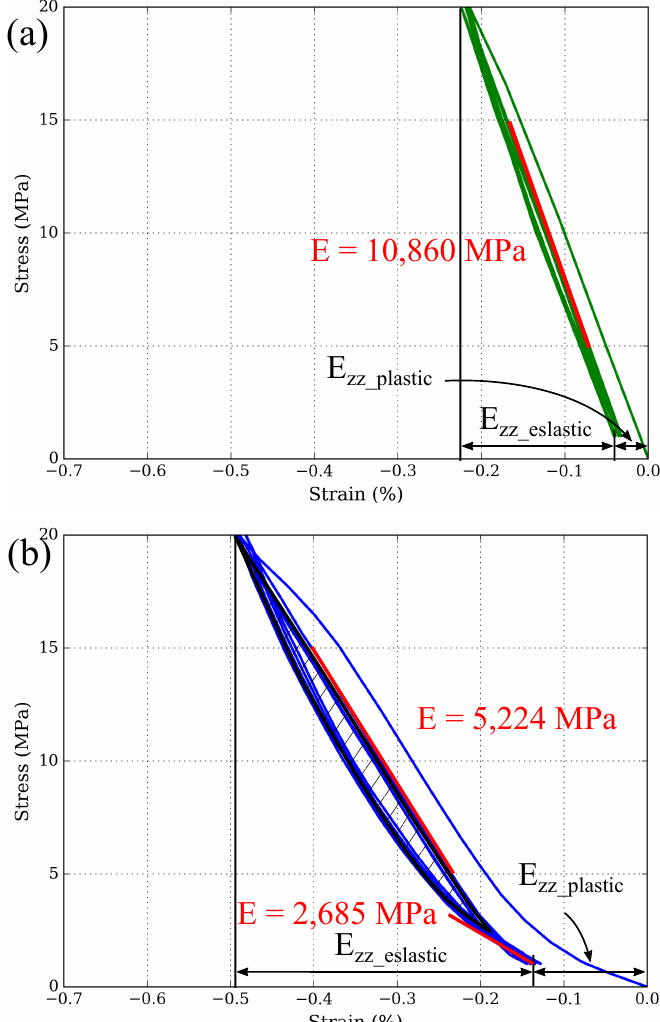
Figure 7. ( a ) Compressive stress-strain (E zz ) curve of MMCsG1 material after prior testing between 0 and 15 MPa. ( b ) Compressive stress-strain (E zz ) curve of MMCsG2 material after prior testing between 0 and 15 MPa. The area of the hysteresis loop is indicated in